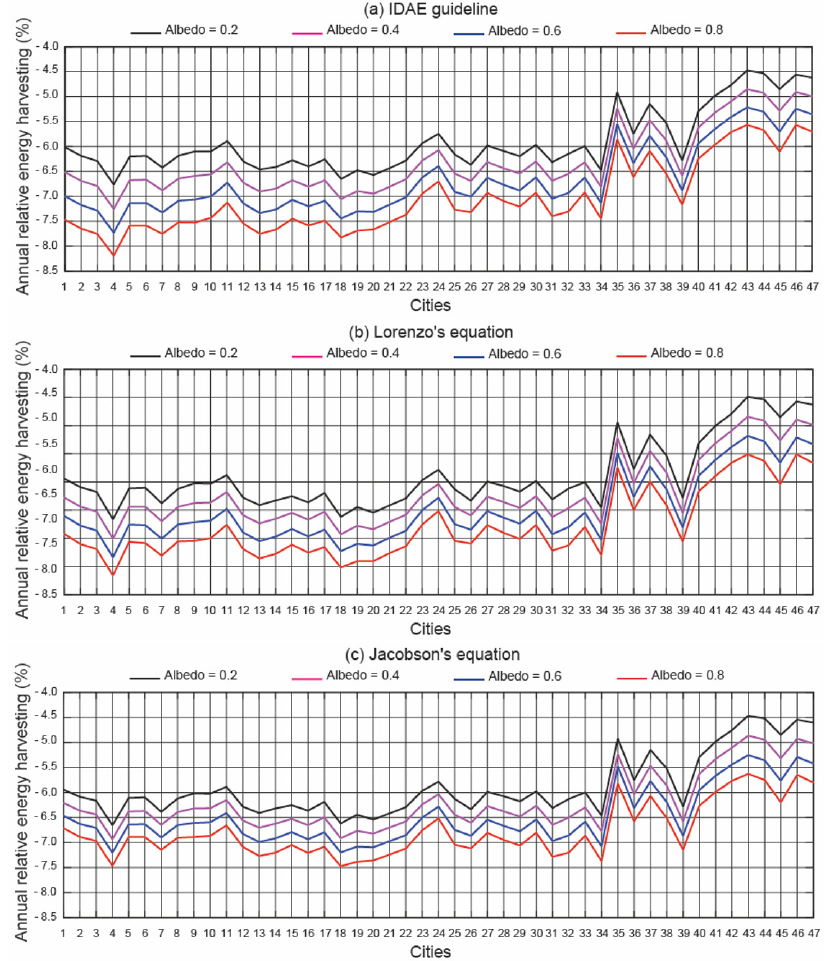
Figure 7. Yearly REH between the equations as function of latitude and single-axis